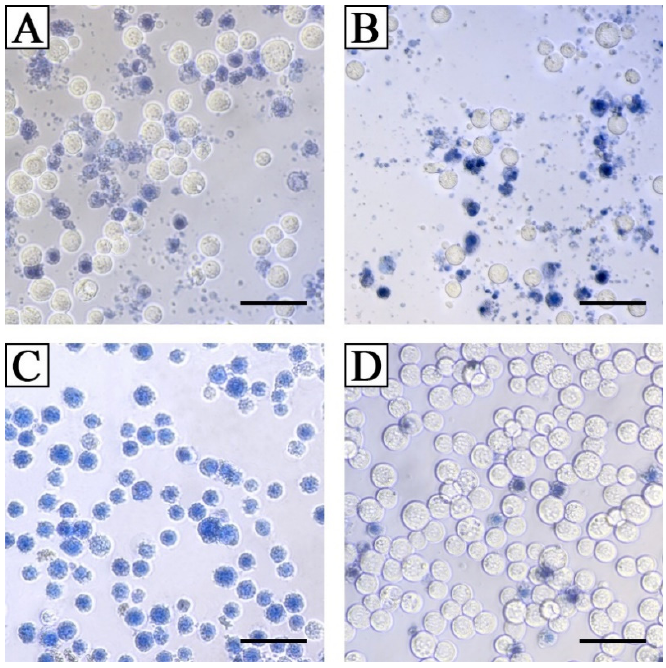
Figure 12. Morphology of Sf9 cells after 24 h of exposure with 15 µg/mL ( A ) and 25 µg/mL ( B ) of tenuazonic acid, and 25 µg/mL of beauvericin ( C ); ( D ) control (1% DMSO). Bar indicates 50 µm.